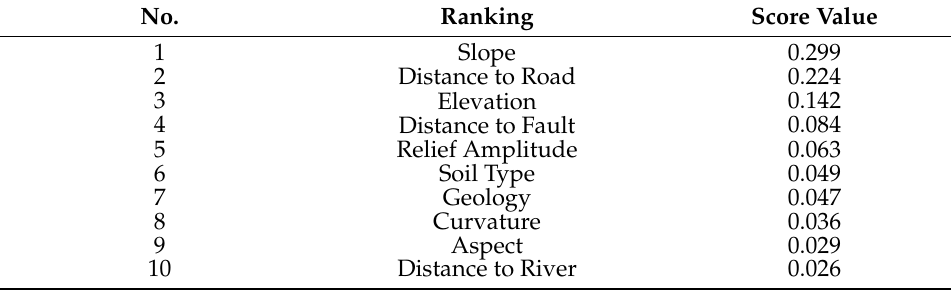
Table 4. The role of the ten influencing